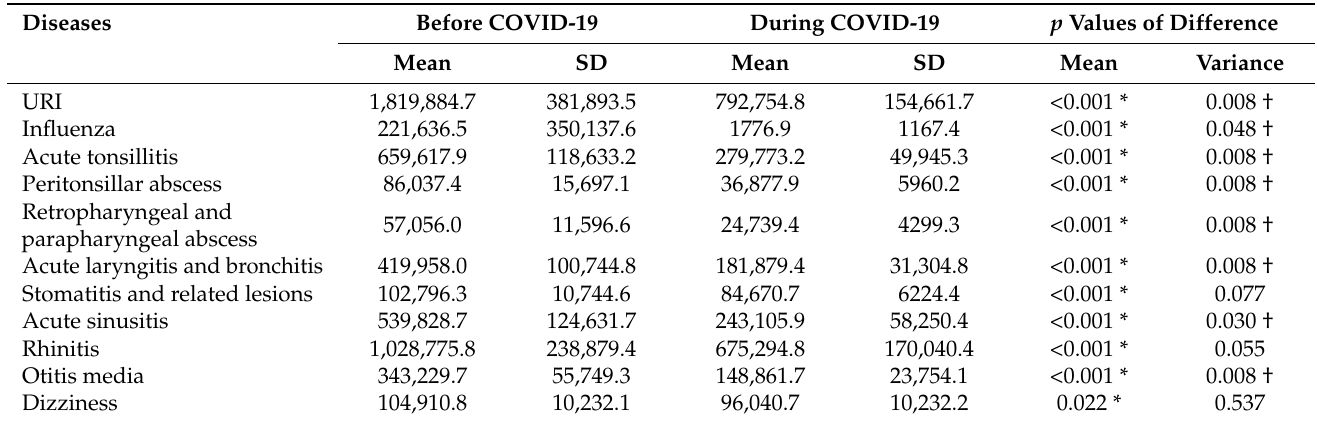
Table 1. Mean and standard deviation of the incidence of diseases before and during COVID-19 and their